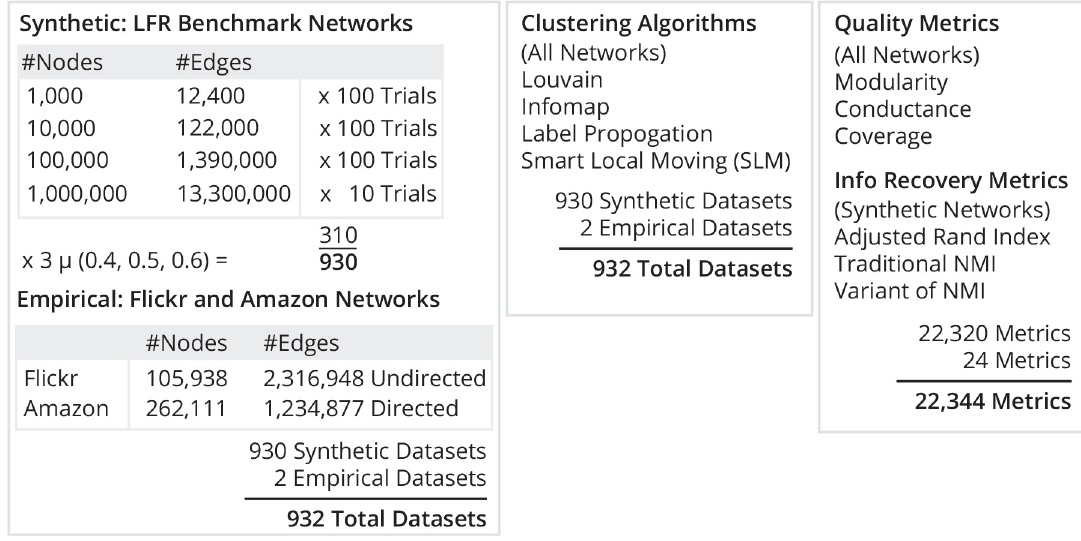
Fig 1. The experimental procedure of our clustering algorithm